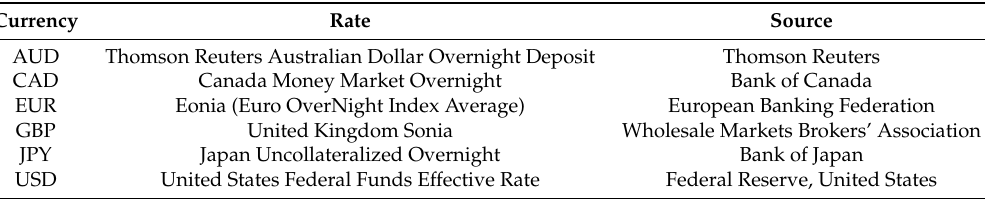
Table 8. Currency and their reference rates.